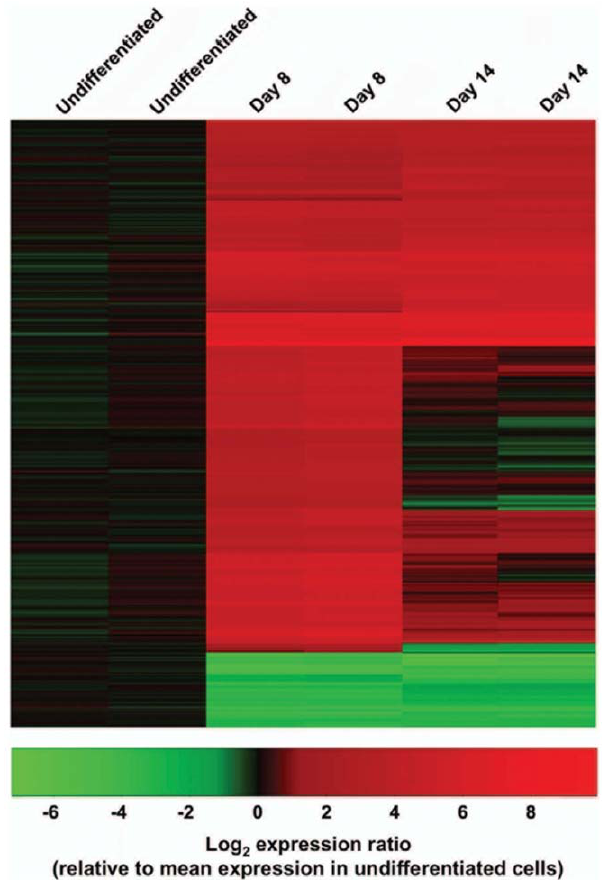
Figure 7. Expression profiling of differentiating hMPs. Relative gene expression in undifferentiated a MHC-GFP hESCs, hMPs sorted from day 8 a MHC-GFP hEBs, and hMPs sorted from day 14 a MHC-GFP hEBs (two samples each) was analyzed. Heat map shows log 2 -fold change (sample intensity/mean intensity for undifferentiated group) for the 830 genes that had statistically significant differences (false discovery rate (FDR) , 0.05) of at least 2-fold in any pairwise comparison between the three